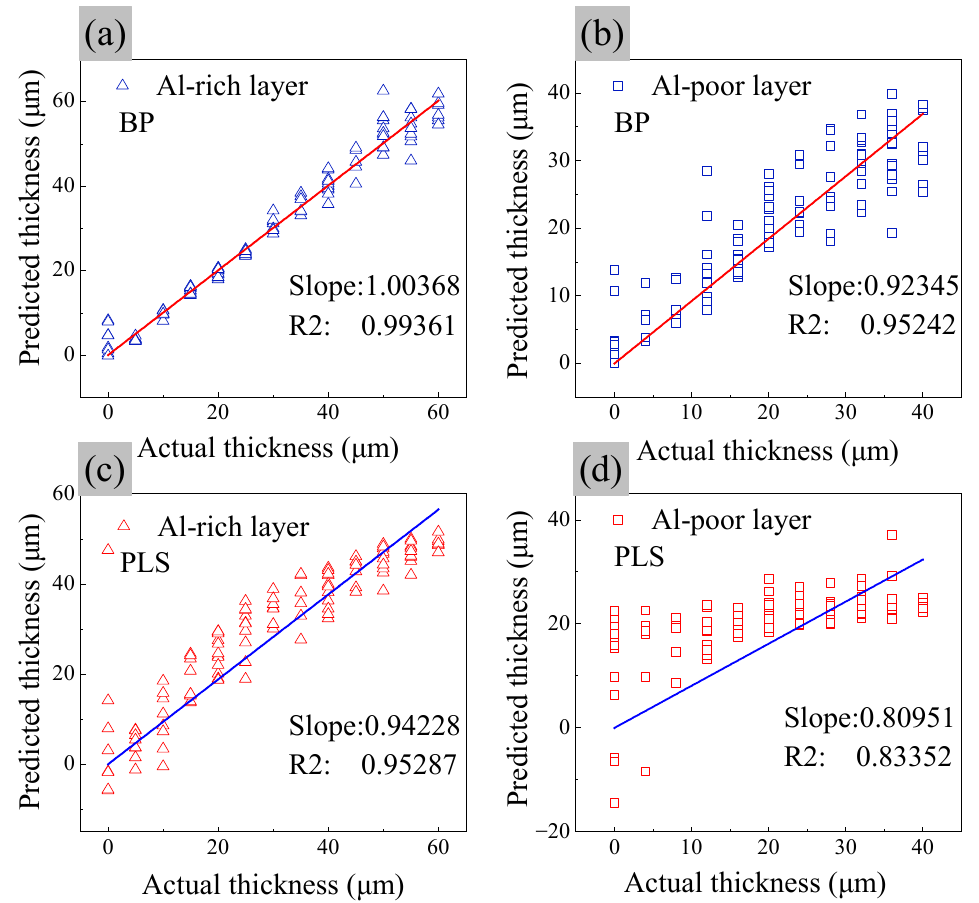
Figure 6. Coating thickness prediction results. ( a ) Prediction results of the BPNN model for Al-rich layer thickness; ( b ) prediction results of the BPNN model for Al-poor layer thickness; ( c ) prediction results of the PLS model for Al-rich layer thickness; ( d ) prediction results of the PLS model for Al-poor layer thickness.